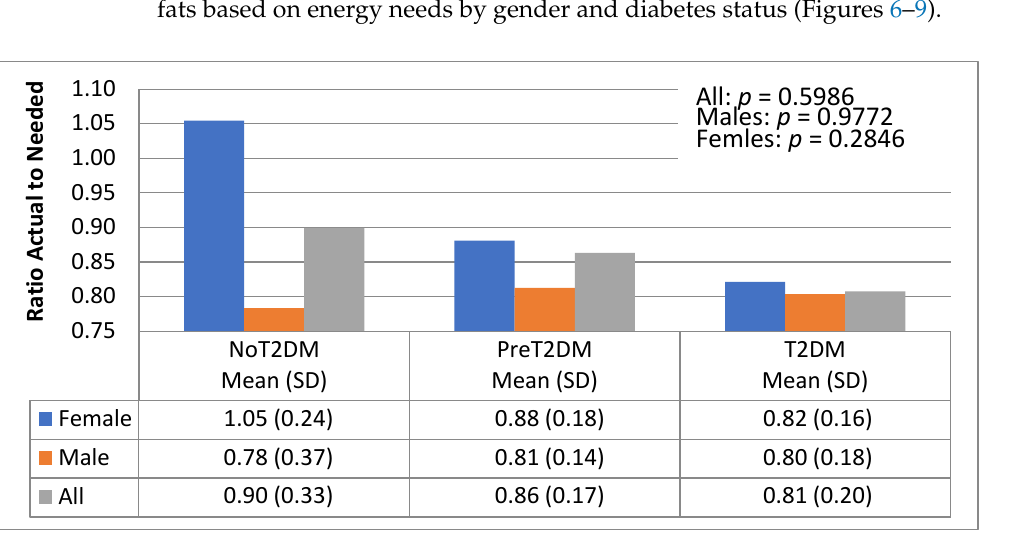
Figure 7. Actual to needed kilocalories from protein by diabetes status and gender. Figure 8. Actual to needed kilocalories from carbohydrates by diabetes status and gender.